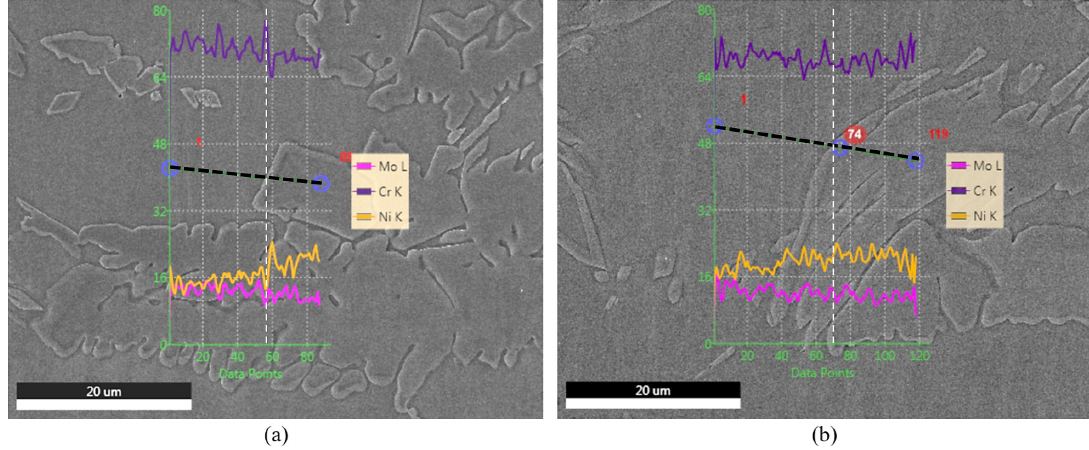
Figure 11. Results of the EDS line analysis (the black line shows the EDS line analysis and the dotted white line shows the position of the austenite/ferrite interface) between α and γ phases at the HAZHT (a) and (b) 1.0 kJ.mm -1 . The austenite presented higher nickel and lower molybdenum contents. These results suggest a compositional gradient in the ferrite matrix, indicating higher Ni and lower Cr and Mo content close to the partially dissolved austenite. These results confirm previous observations suggesting solute segregation in the ferrite (see Figures 7 and 8). SEM, BEI, electrolytic etching in oxalic acid Table 4. Results of the EDS analysis on the different weld regions. Welding energy